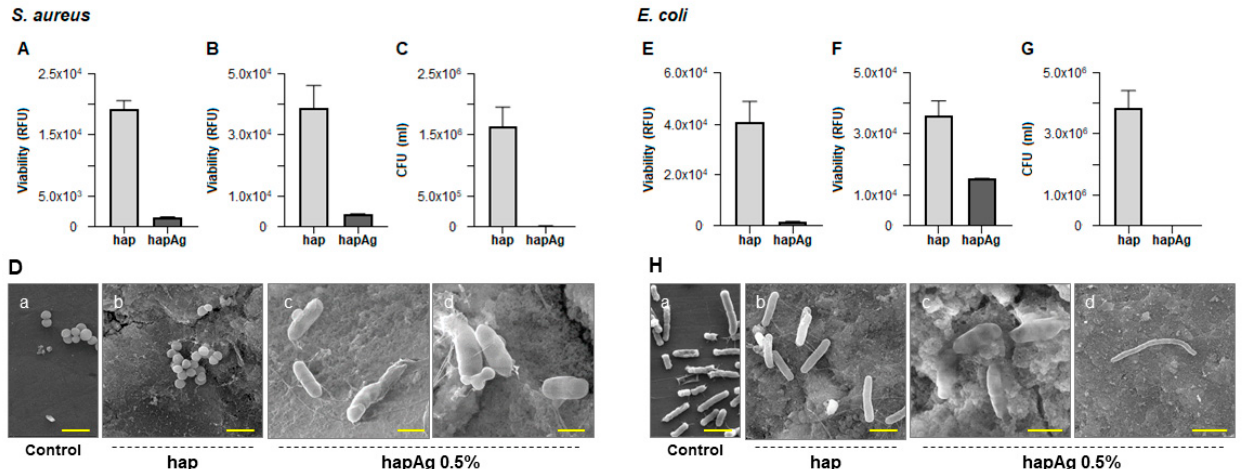
Figure 10. Antibacterial activity of hapAg pellets against S. aureus ( A – D ) and E. coli ( E – H ). Viability of planktonic bacteria ( A , E ), sessile bacteria ( B , F ), CFUs counts of sessile bacteria ( C , G ) and SEM observation ( D , H ). Control (standard tissue culture plate). Bar: ( D )—2 µ m ( a , b ), 1 µ m ( c ) and 0.5 µ m ( d ); ( H )—2 µ m ( a , b ), 1 µ m ( c ) and 10 µ m ( d ).